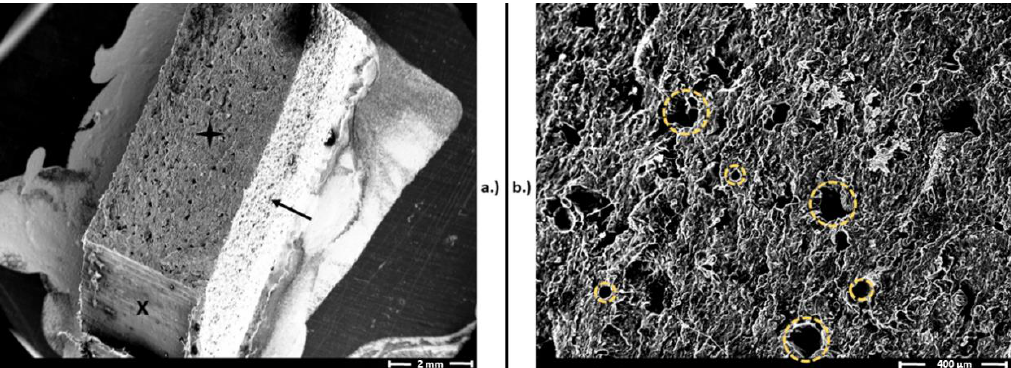
Figure 5. Scanning electron microscopy (SEM) images of a polyamide (PA) (selective laser sintering (SLS)) test bar after the Charpy impact test. ( a ) Broken surface of the test specimen, marked with a black star, similar to the intact surface (black arrow). The “X” represents a surface after cutting the test specimen to prepare the SEM sample. Magnification: 10×. ( b ) Surface and pores of PA test bars from the broken surface. The yellow dashed circles represent the pores, with sizes varying from 15 to 150 µm. Magnification: 60×.